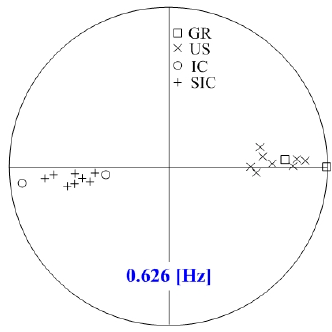
Figure 10. Sync of the interarea mode. GR: Gori area generators; US: Ulsan area generators; IC: Incheon area generators; and SIC: Seoincheon area generators.